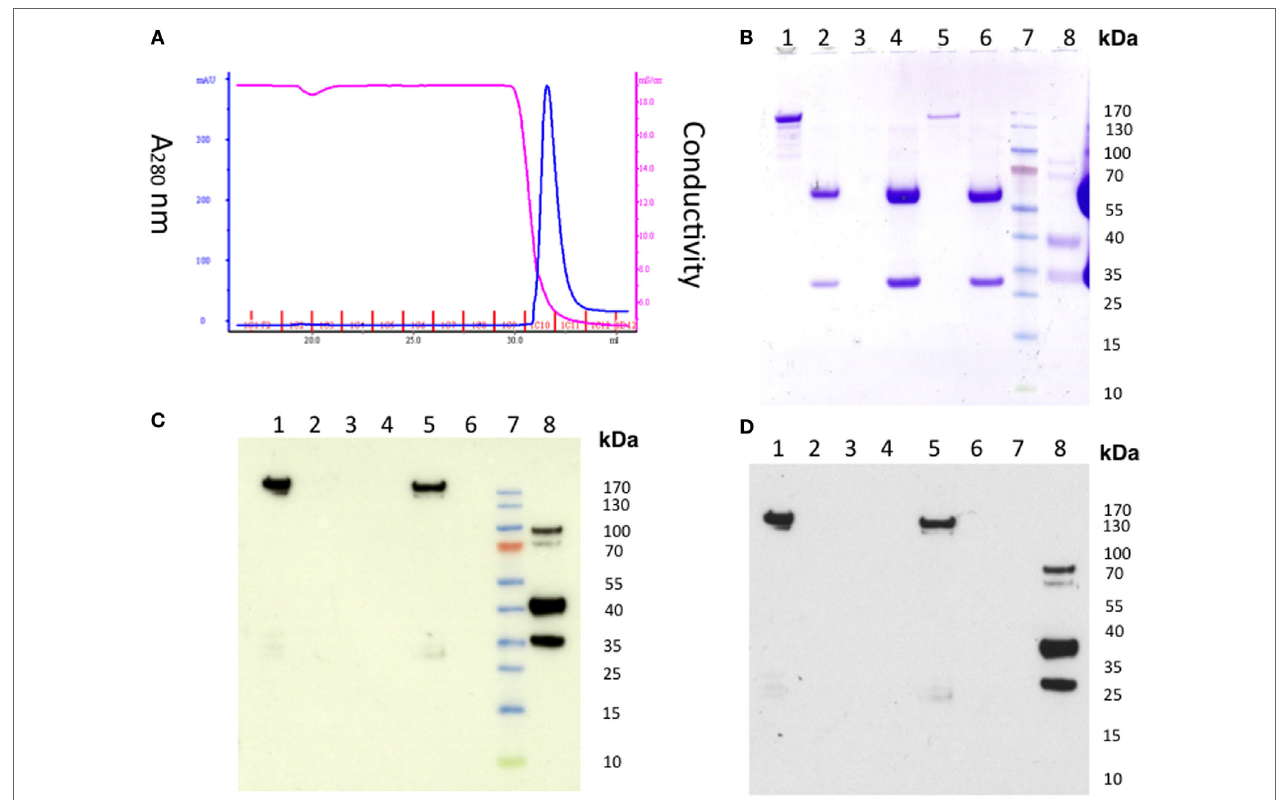
FigUre 4 | Detection of residual endo- β - N -acetylglucosaminidase (EndoS) in the GST-EndoS treated IgG after protein G purification. M2139 antibody (2 mg) was incubated with 0.1 µg or 1 µg of EndoS in PBS at 37°C for 1 h followed by immediate purification on HiTrap Protein G HP column (a) Chromatogram. The flow through fraction and the eluate were analyzed by SDS-PAGE followed by Western blot. (B) SDS-PAGE and Western blot using (c) alkaline phosphatase or (D) peroxidase conjugate as secondary antibody. Flow-through samples were concentrated before loading on to SDS-PAGE. After transfer, the Western blot membrane was incubated with Eu-N1-labeled anti-GST antibody, followed by donkey anti-goat AP or anti-goat HRP conjugate. For the AP conjugate, the positive bands were visualized using 1-Step TM NBT/BCIP substrate. For the HRP conjugate, the light emission was enhanced using ECL followed by film exposure. Lane 1, EndoS; lane 2, M2139; lane 3, concentrated flow through (0.1 mg group); lane 4, eluate (0.1 mg group); lane 5, concentrated flow through (1 mg group), lane 6, eluate (1 mg group); lane 7, protein standard; lane 8, control GST-fusion